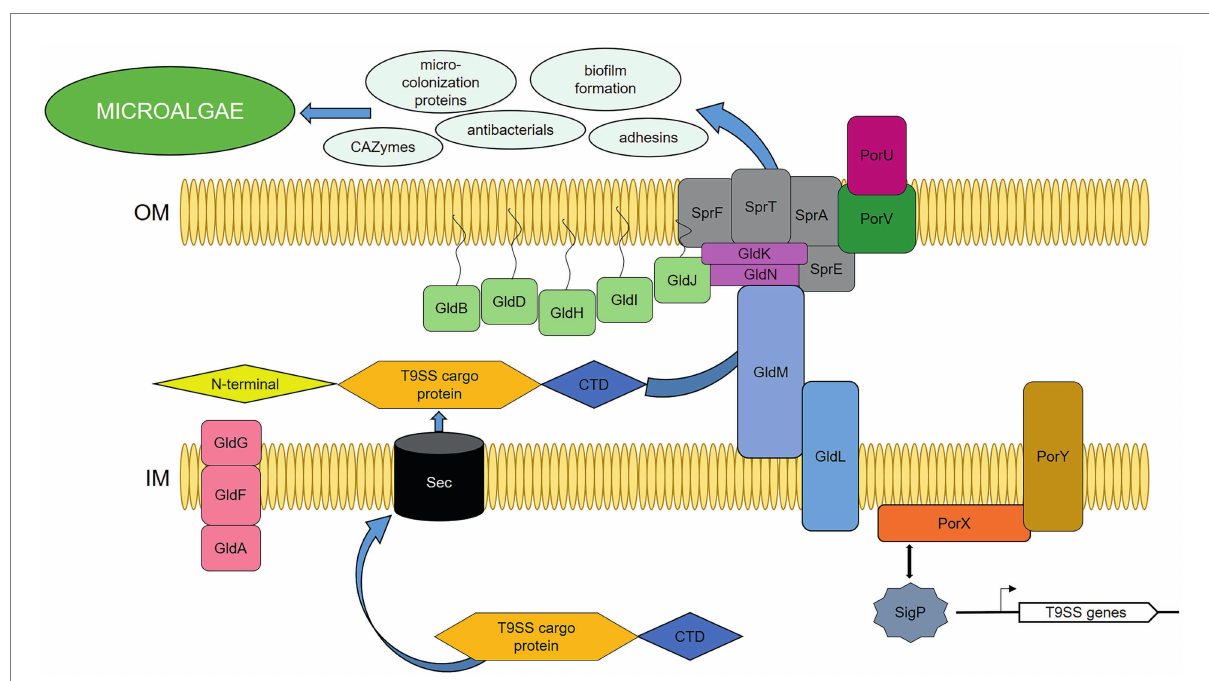
FIGURE 5 Proposed model of T9SS in Dyadobacter sp. HH091, serving as the secretion system of cargo-proteins. PorXY-SigP signalling system upregulates several components: T9SS category (GldK, GldL, GldM, GldN, SprA, SprE, SprF, SprT, PorU, PorV), and further Gld proteins (GldA, GldB, GldD, GldF, GldG, GldH, GldI, GldJ). C-terminal domain (CTD), N-terminal signal peptide (N-terminal), outer membrane (OM), inner membrane